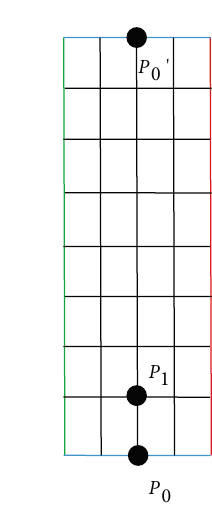
Figure 4: The physical grid (a) and computational grid (b). The corresponding boundary edges of two domains are indicated by the same color.